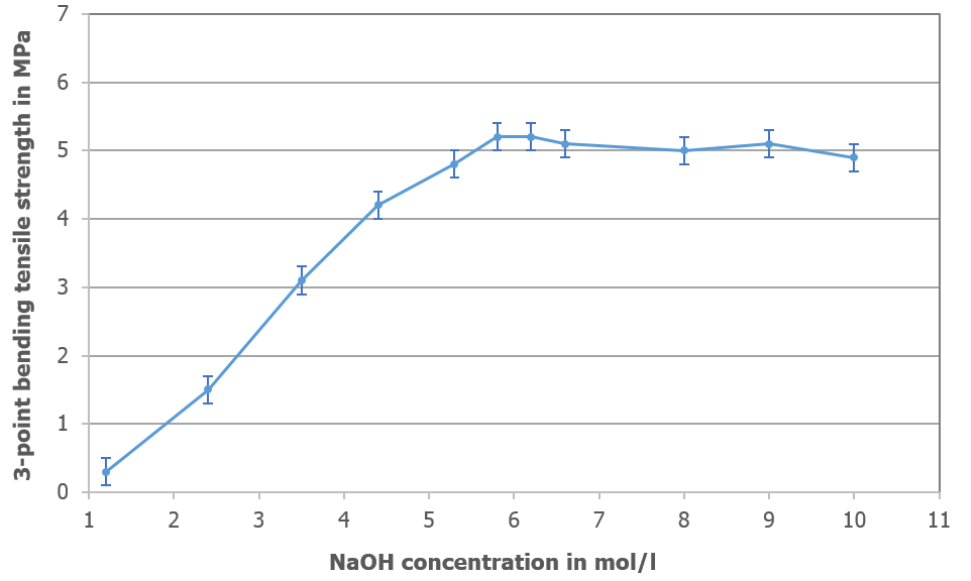
Figure 2. Three-point bending tensile strength as a function of the NaOH